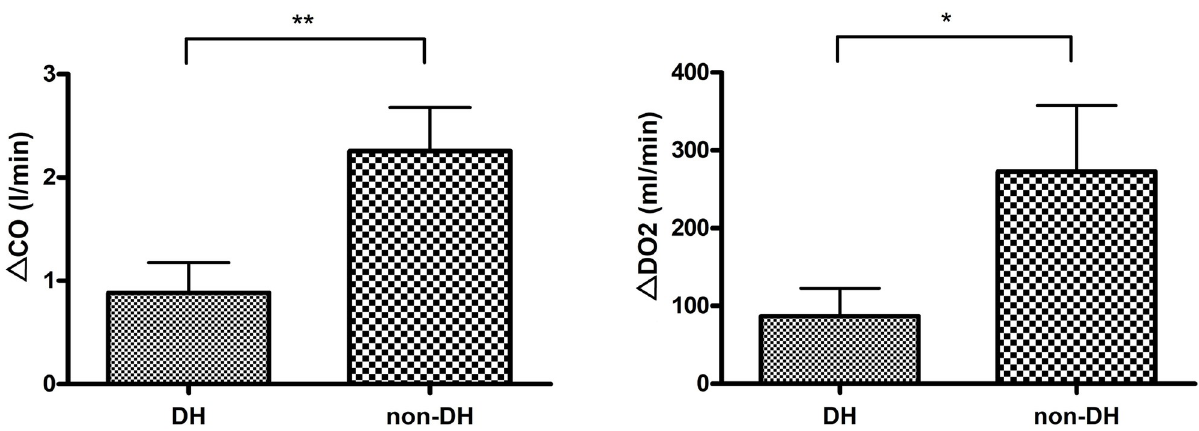
Fig 3. Comparison of Δ CO and Δ DO 2 value in the DH and non-DH groups. CO: cardiac output, DO: oxygen delivery, DH: dynamic hyperinflation ( �� p < 0,01; � p < 0,05).